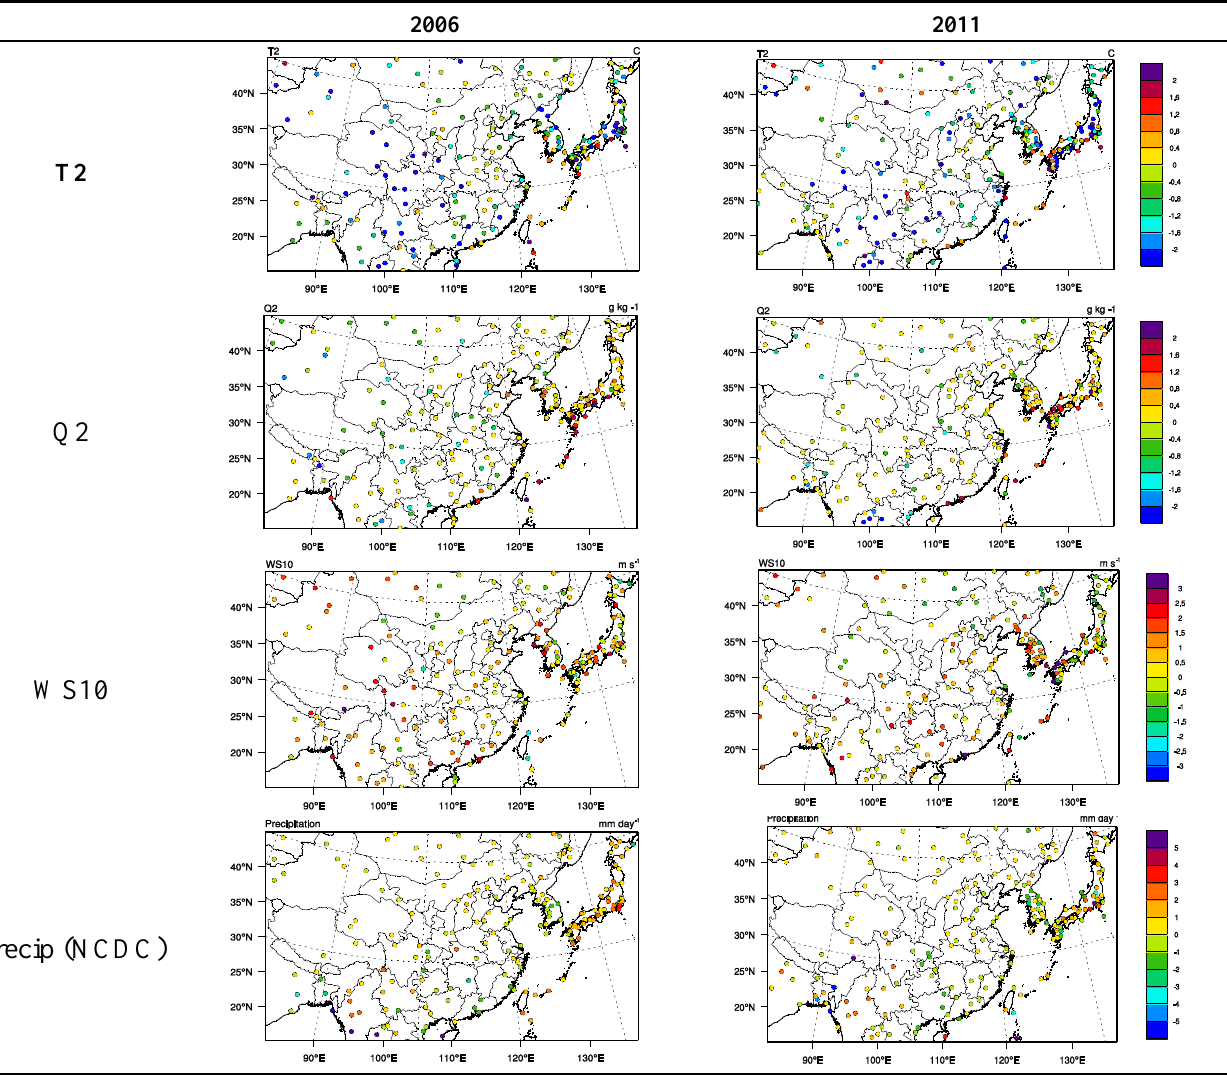
Figure 1 . Spatial distribution of annual mean MBs of T2, Q2, WS10, and precipitation against NCDC dataset for the 2006 and 2011 WRF-CAM5 simulations with